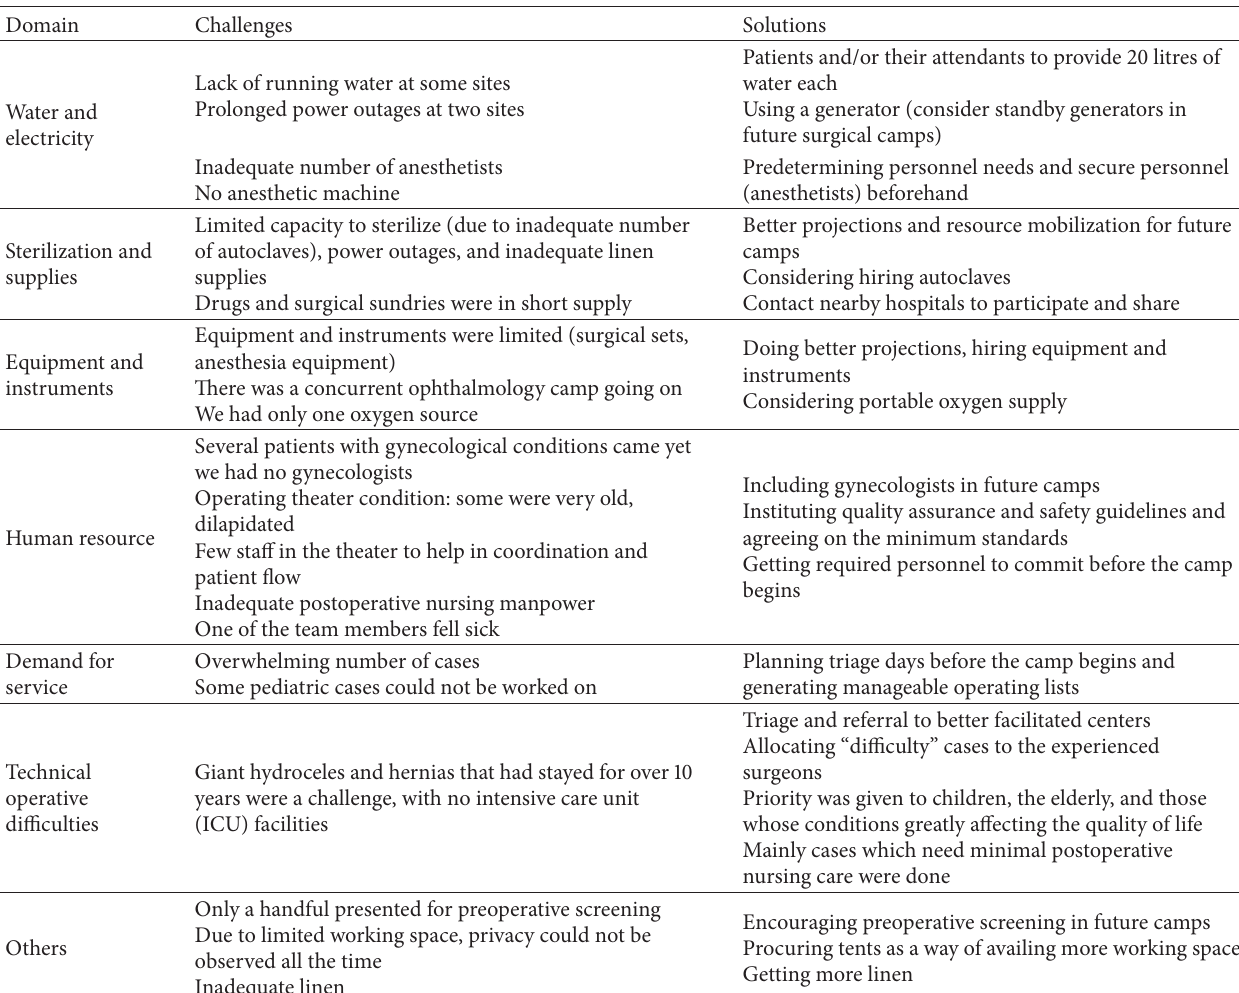
Table 4: Challenges reported, solutions, and future